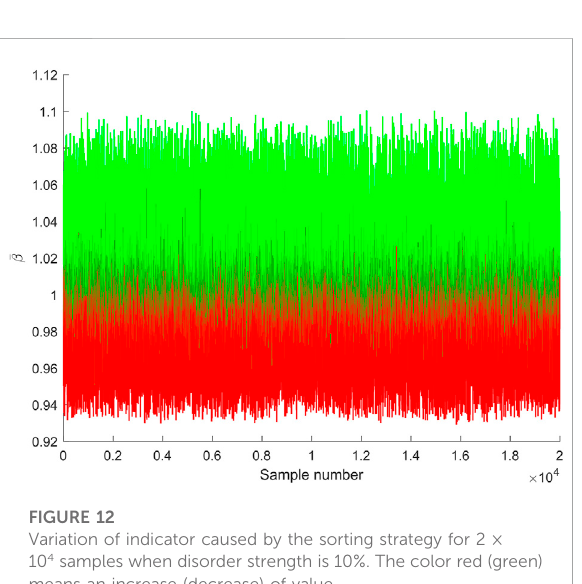
FIGURE 14 Variation of the indicator caused by the sorting strategy